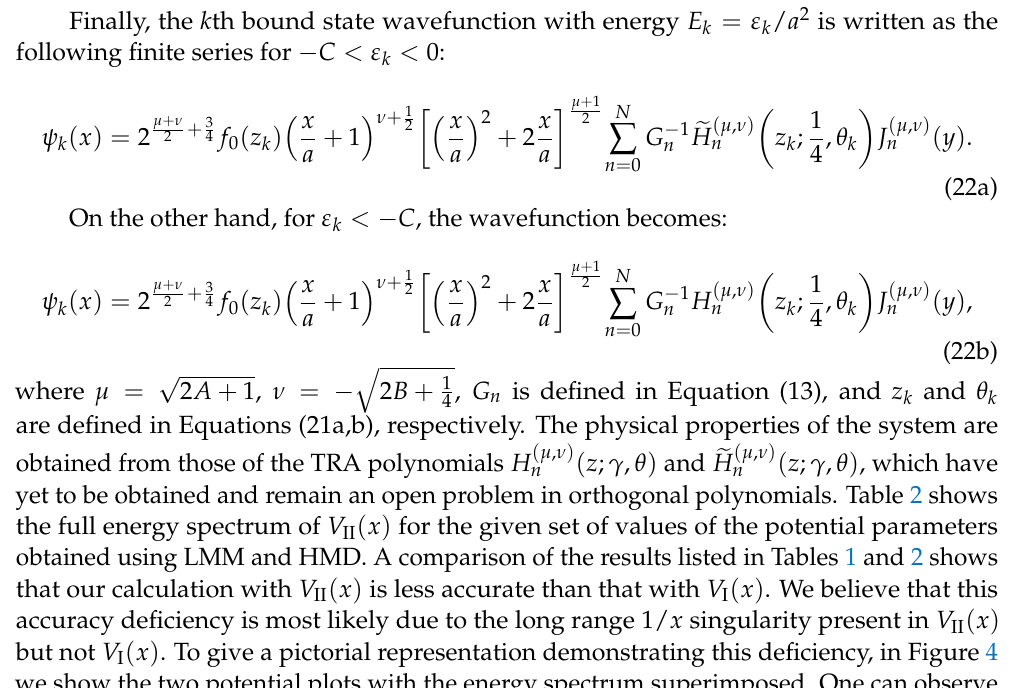
4 3 10 − × average deviation (defined as the